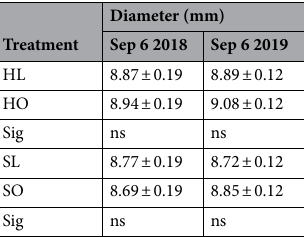
Table 3. Effect of lateral removal on the shoot diameter of ‘Riesling’.